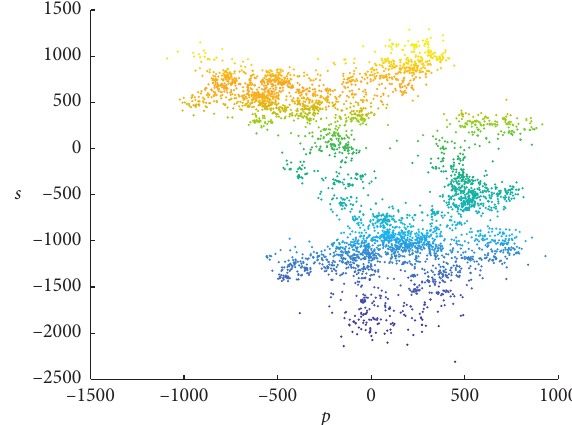
Figure 6: Phase in p - s plane for PM2.5 concentration.